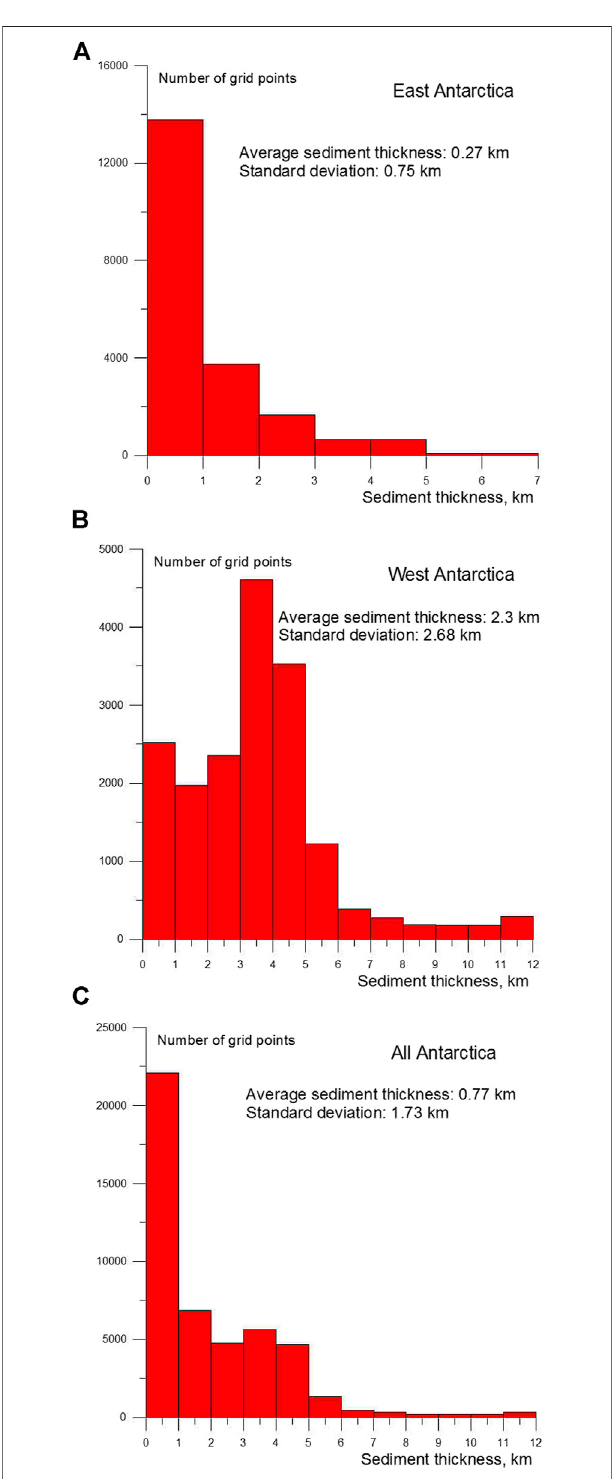
FIGURE 4 | Histograms of the total sediment thickness for (A) East Antarctica, (B) West Antarctica and the whole continent (C) .